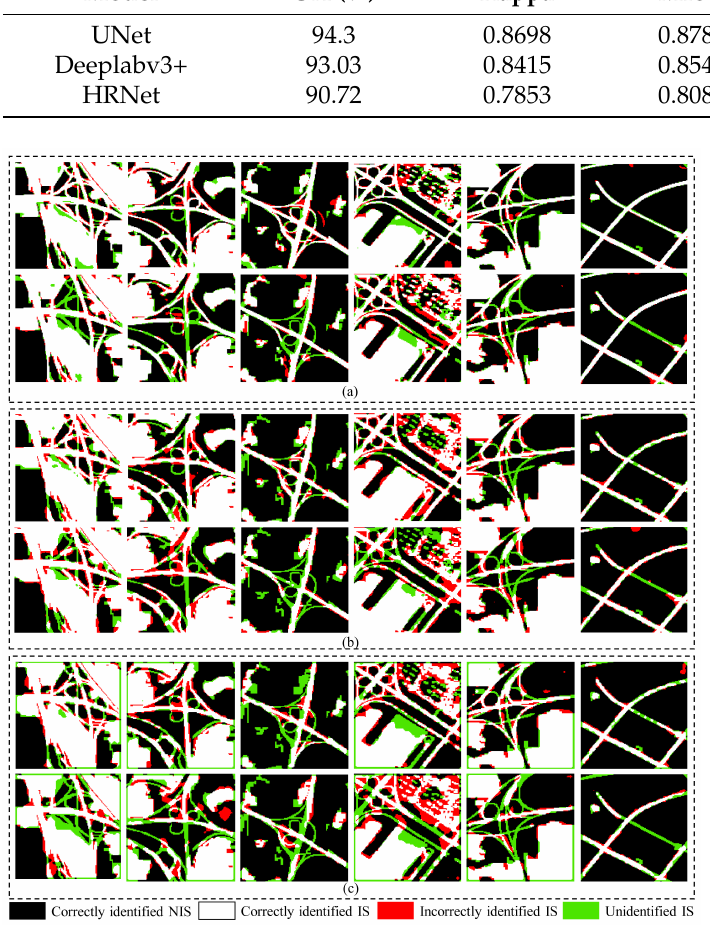
Figure 15. Comparison of impervious surface extraction results of models before and after adding road network data. ( a – c ) The extraction results of impervious surfaces detected by UNet, Deeplabv3+, and HRNet before (the second row) and after (the first row) adding the OSM road network